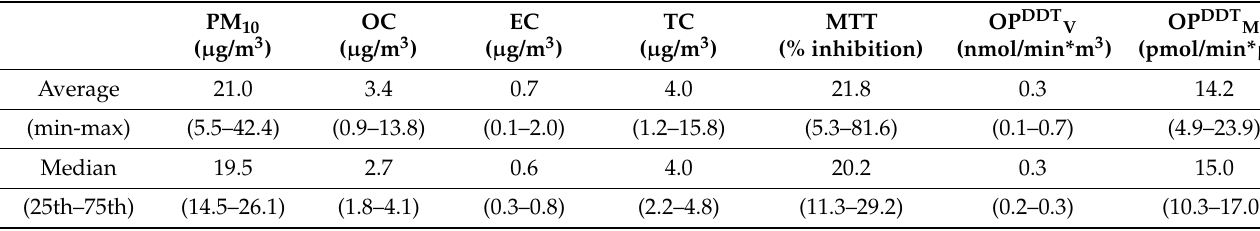
Table 1. Values of PM 10 concentrations, carbon content, cytotoxicity (assessed by MTT test), and oxidative potential (OP), referred to as the sampled volume (OP DTT V ) or sampled mass (OP DTT M ).